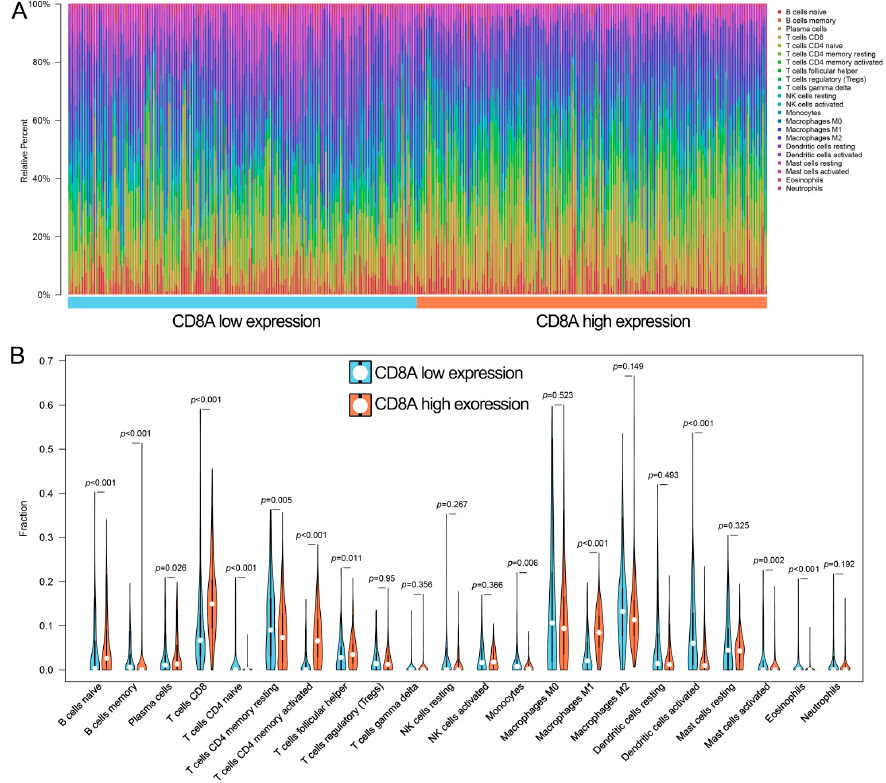
Figure 6. The landscape of 22 TIICs in TCGA-BCa. ( A ) The proportions of 22 TIICs in each sample quantified by CIBERSORT algorithm. ( B ) The difference of the proportions of 22 TIICs between high and low CD8A expression groups. TCGA, The Cancer Genome Atlas; BCa, bladder cancer; TIICs, tumor-infiltrating immune cells; CIBERSORT, cell type identification by estimating relative subsets of RNA transcripts.